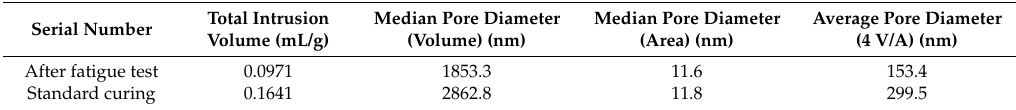
Figure 9. Pore size distribution of the CA mortar under the standard curing condition and after the fatigue test at 50 Hz but at the same total curing age. Table 6. Characteristic parameters of the pore structure for the hardened CA mortar before and after fatigue test.